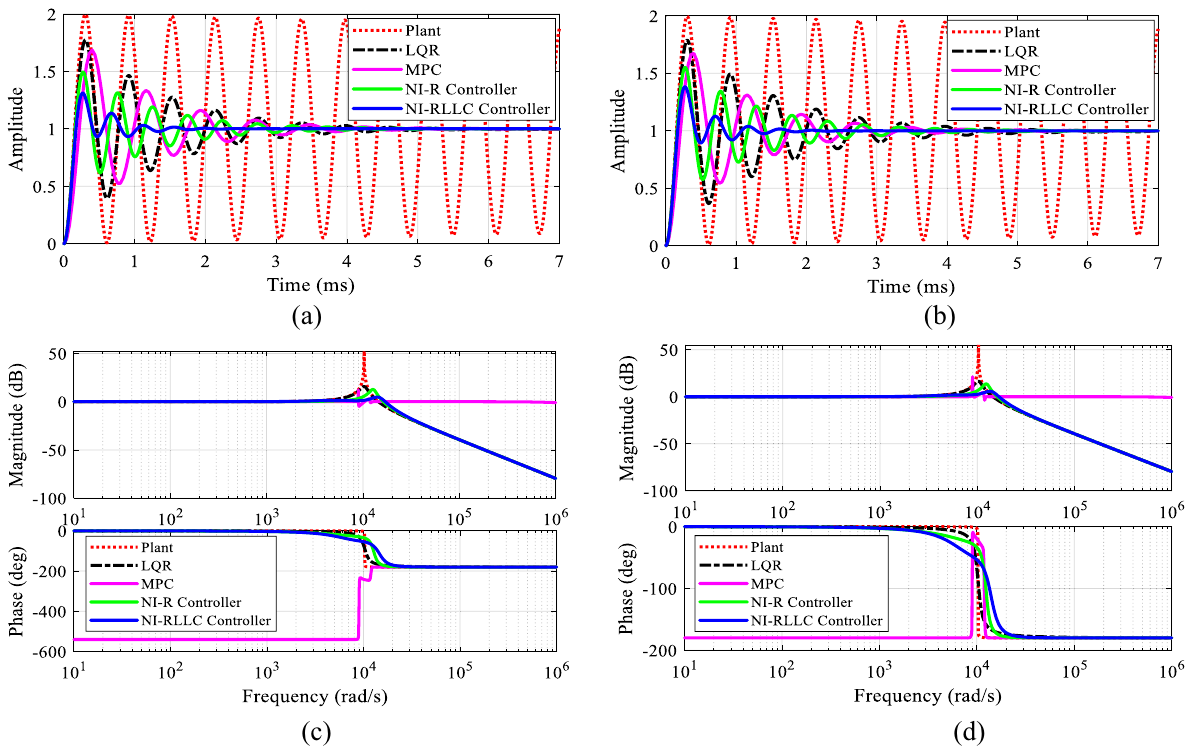
Fig. 7 Three‑phase step response comparison for different controllers for a d ‑axis and b q ‑axis; bode plot comparison for different controllers for c d ‑axis and d q ‑axis